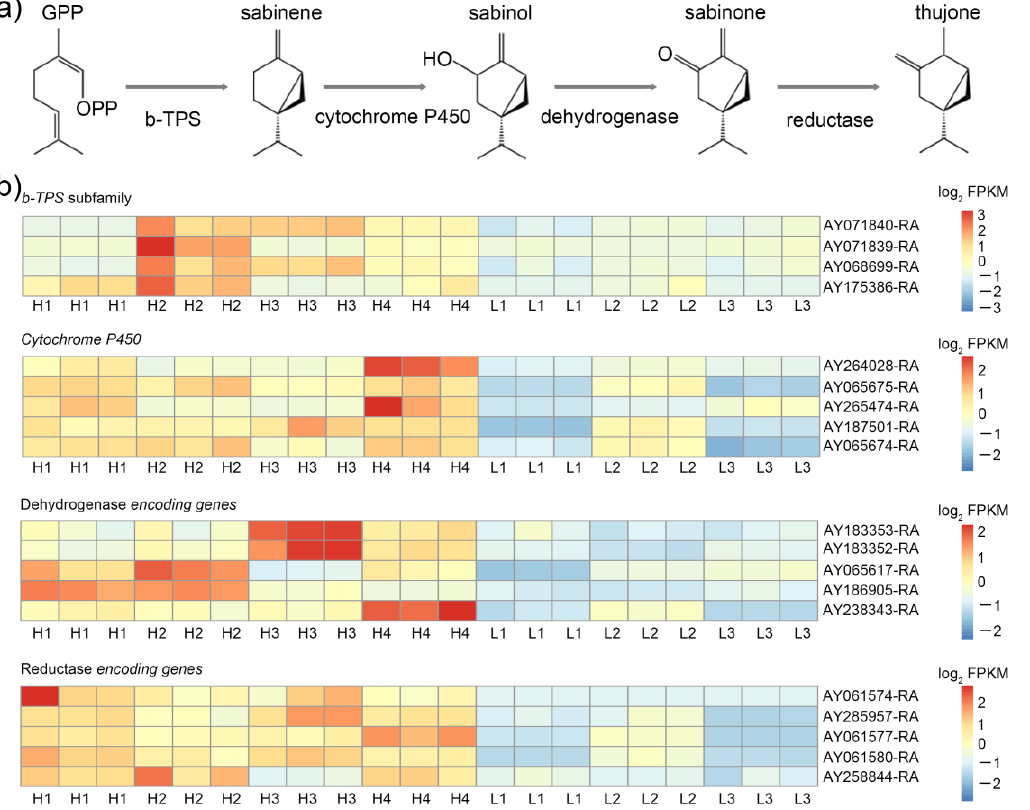
Figure 4. The identification of DEGs involved in the thujone synthetic pathway. ( a ) The proposed thujone synthetic pathway. There are a total of four steps in the metabolic pathway from GPP to thujone. ( b ) Upregulated genes encoding b-TPS, cytochrome P450, dehydrogenase, and reductase in A. argyi varieties with high thujone content compared to A. argyi varieties with low thujone content. H1, H2, H3, and H4 indicate four varieties with high thujone content. L1, L2, and L3 indicate three varieties with low thujone content.